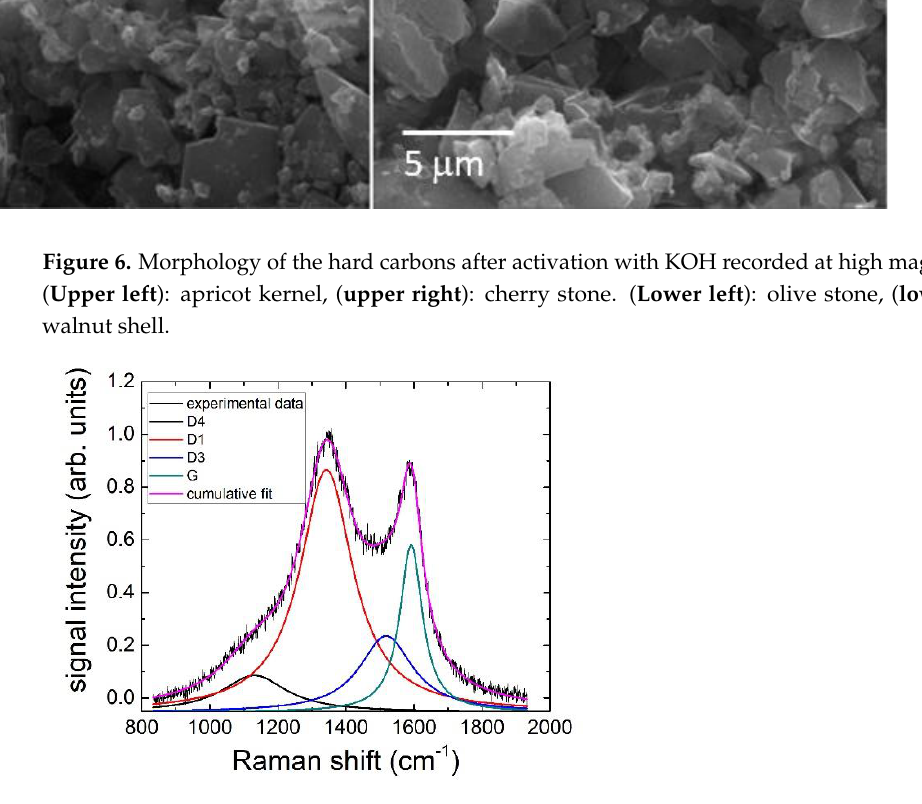
Figure 7. Raman spectrum measured on carbon obtained from the activated apricot kernel, together with its spectral decomposition into the D1, D3, D4, and G bands.